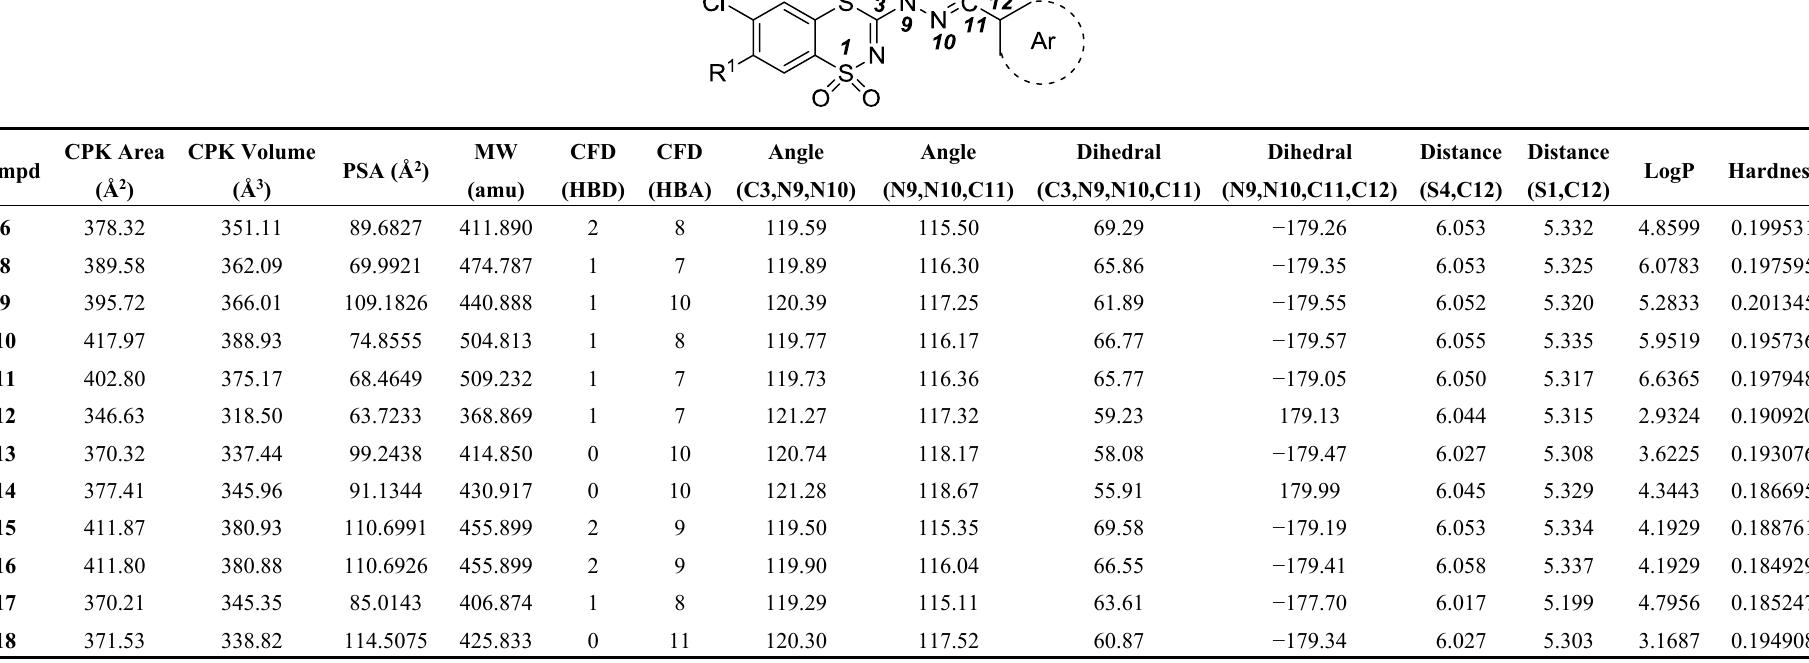
Table 2. Theoretical molecular parameters of compounds 6 , 8 ‒ 18 : CPK Area, CPK Volume, PSA, MW, CFD (HBD), CFD (HBA),